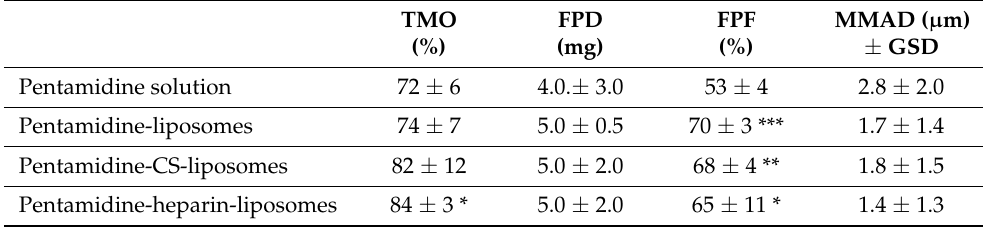
Table 4. Total mass output (TMO), fine particle dose (FPD), fine particle fraction (FPF) and mass me- dian aerodynamic diameter (MMAD) ± geometric standard deviation (GSD) measured for nebulized pentamidine, free in solution or encapsulated in liposomes. Mean values ± standard deviations are reported for TMO, FPD and FPF ( n =